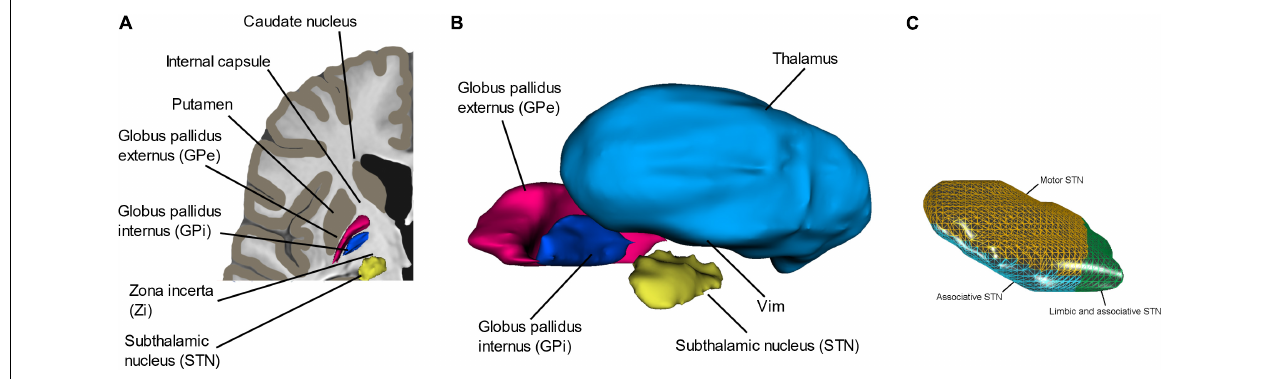
FIGURE 2 | (A,B) The most common deep brain structures (VIM, Zi, GPi, and STN) used for DBS implantation in movement disorder. (C) An enlargement of the subthalamic nucleus (STN) and its motor, limbic, and associative/limbic part. Panel (C) with permission from Åström